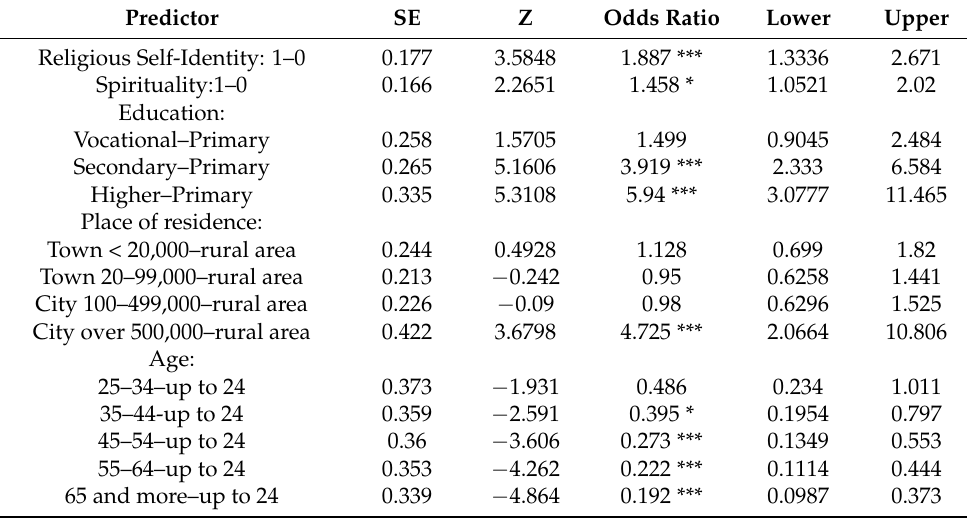
Table 6. Model Coefficients–Cultural Participation.